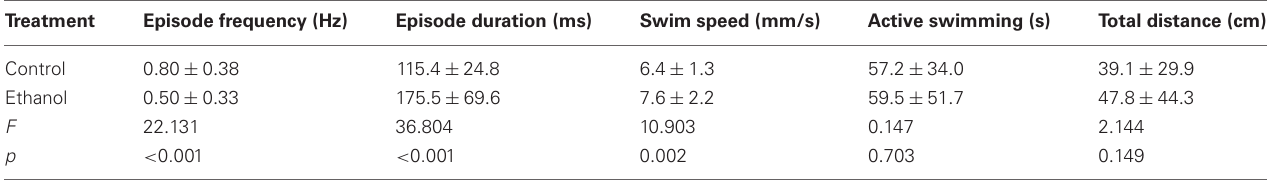
Table 4 | Comparison of the properties of locomotor activity for larvae in control and ethanol treated groups.